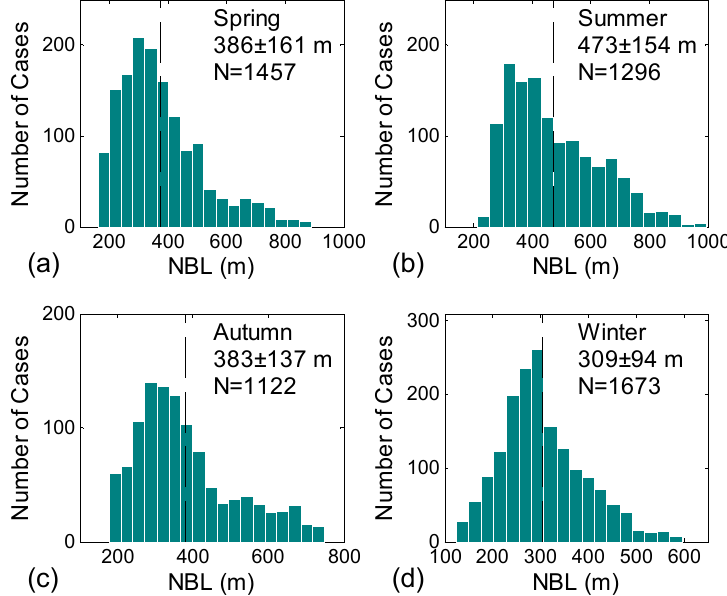
Figure 5. Histograms showing the frequency distribution of NBLHs for all measurements (2012–2016) as a function of seasons for bins of every 30 m interval. The dashed line on each panel marks the seasonal mean of NBLHs. Seasonal mean values with corresponding standard deviations are also shown in the top right corner of each panel. ( a ), ( b ), ( c ) and ( d ) represent spring, summer, autumn and winter, respectively.